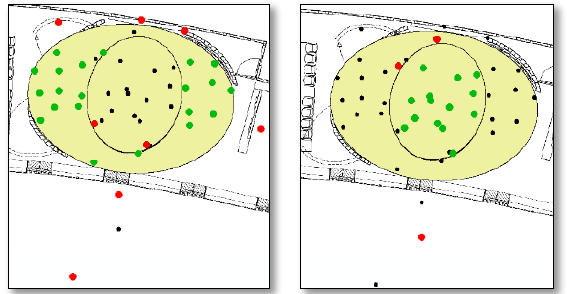
Figure 6: Correctly and incorrectly assigned points with respect to the dedicated polygon. On the table (left) and around the table (right).